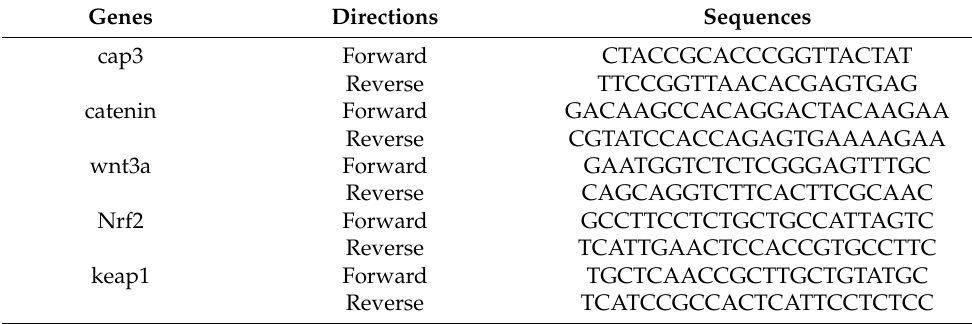
Table 1. Primers for real-time polymerase chain